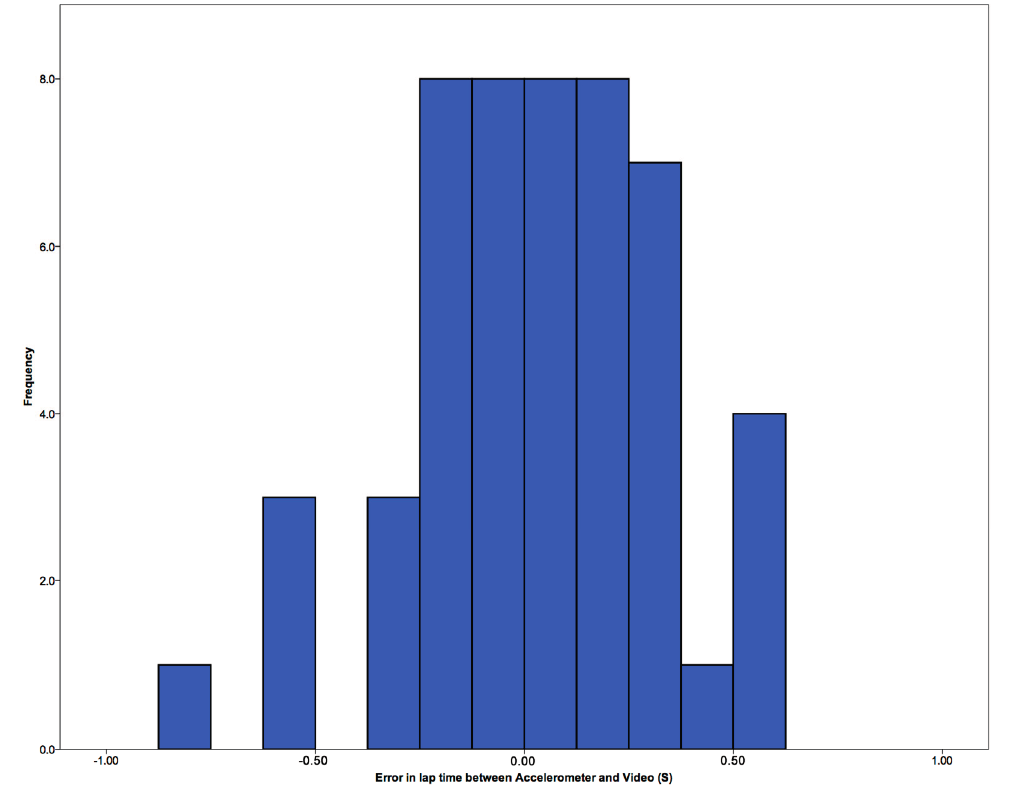
Figure 7. Error in seconds between video and accelerometer automatically selected lap